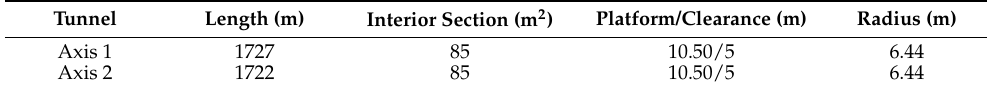
Figure 3. Functional section of the Arnotegi tunnel (5 m vertical clearance). Table 1. Main geometrical characteristics in Arnotegi tunnel.